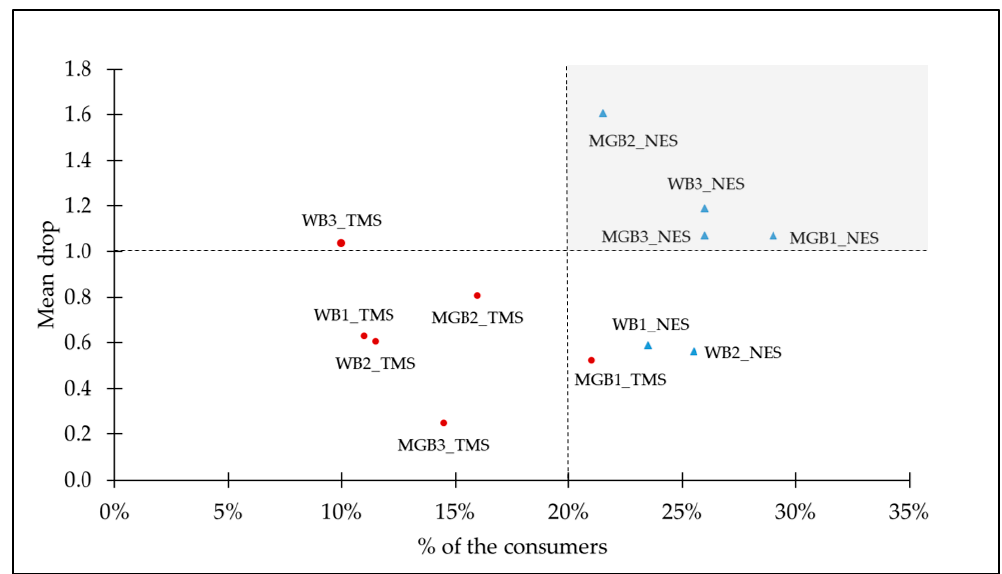
Figure 1. Penalty analysis. Mean liking drops in points on a 7-point hedonic scale and size of the non-JAR sub-groups (%) ( n = 200).